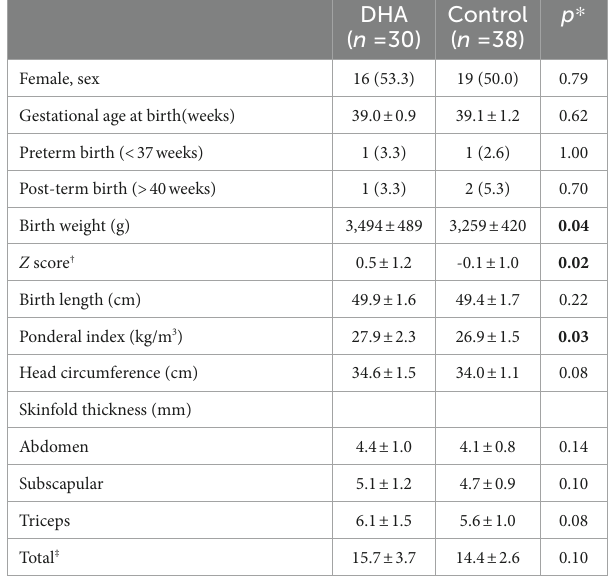
TABLE 3 Cord blood DHA in erythrocytes and serum biomarkers in women with GDM in DHA supplementation vs. control